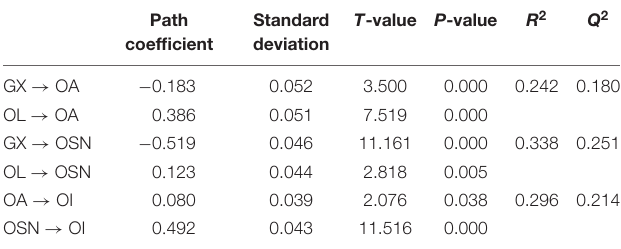
TABLE 5 | Path analysis.